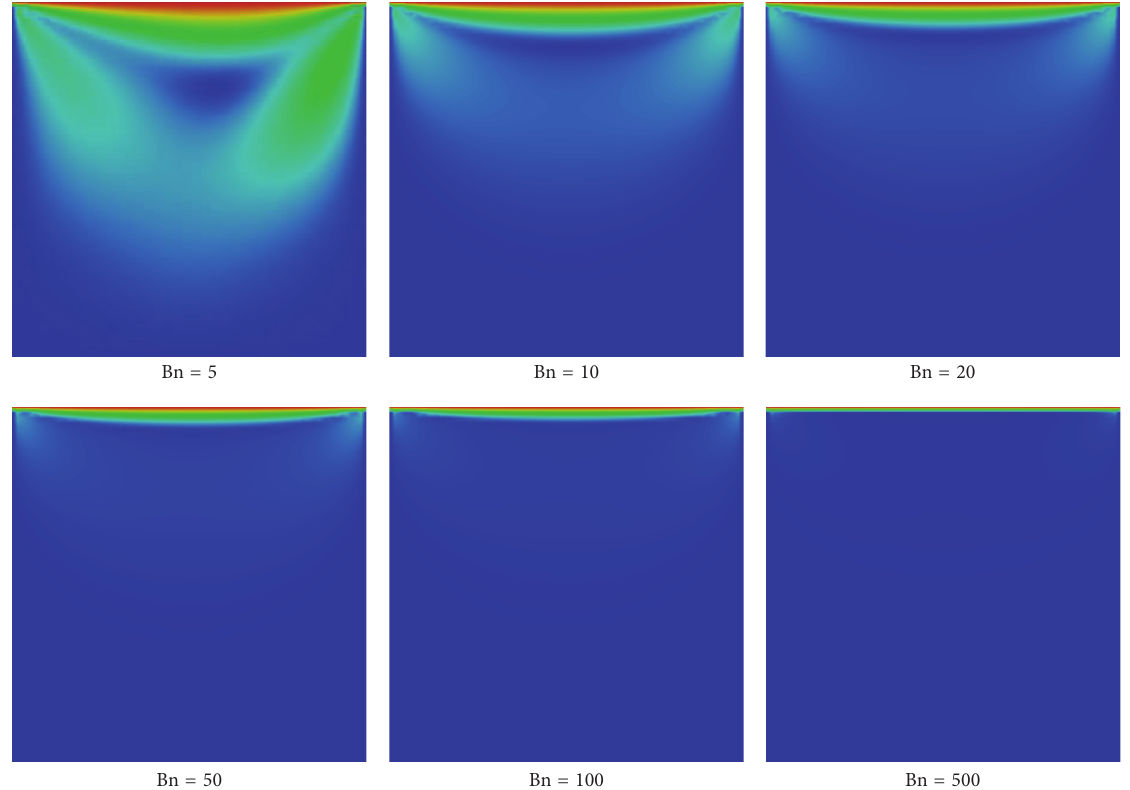
Figure 3: Velocity profiles for different values of Bingham numbers Bn.